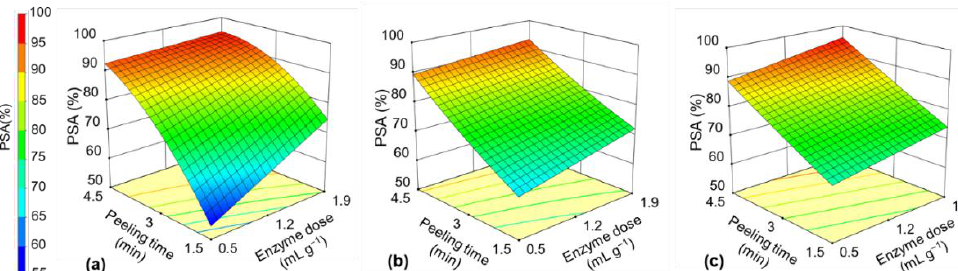
Figure 1. Peeled surface area (PSA) of cassava tubers after enzyme treatment and mechanical peeling vs. peeling time and the enzyme dose at an incubation time of 4 h; ( a ) small, ( b ) medium and ( c ) large size of cassava tubers.